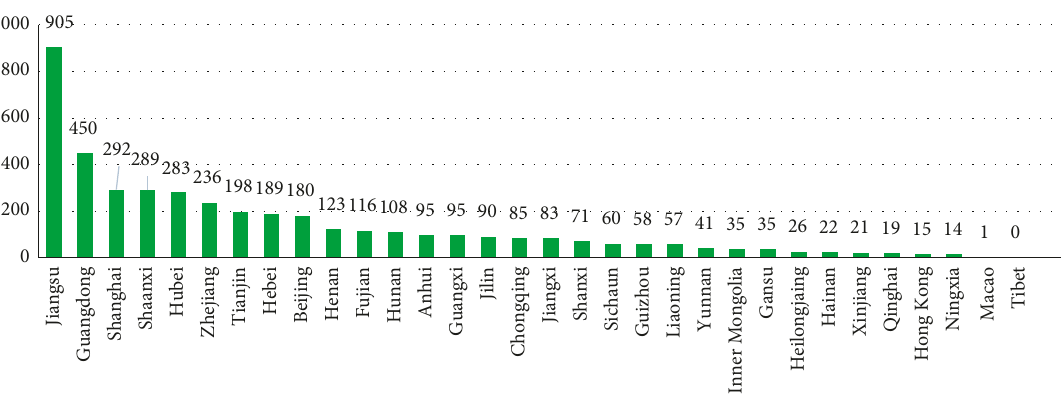
Figure 3: Green building evaluation marking project